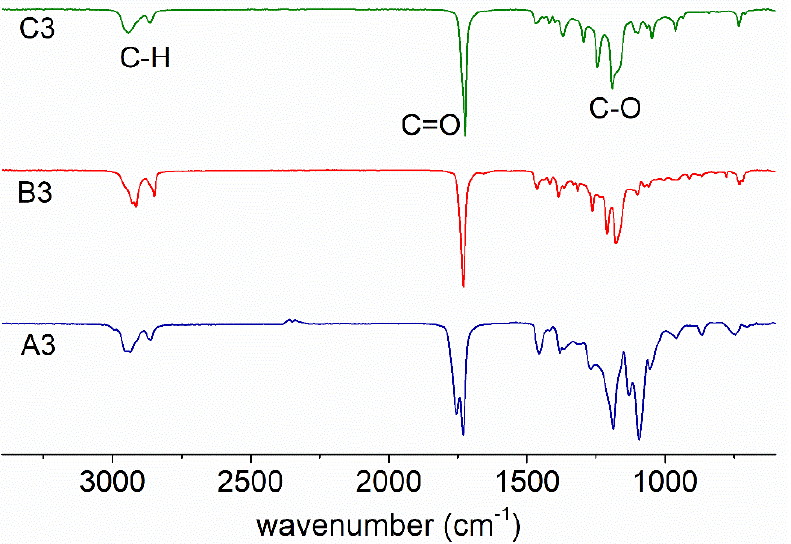
Figure 3 . Absorption bands of characteristic functional groups through FTIR in A3, B3 and C3.